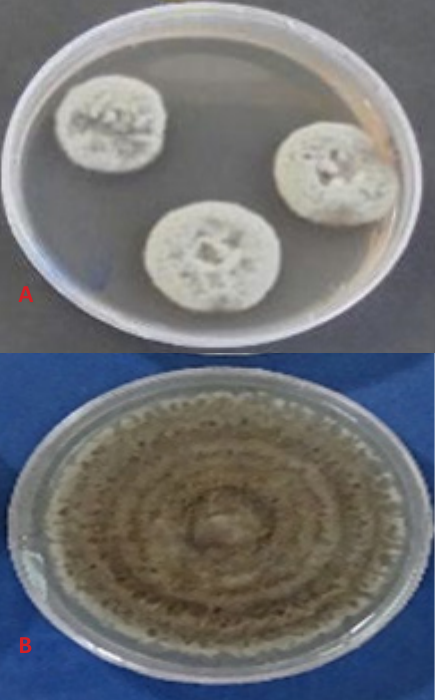
Figure 2 . Leaf samples sown in potato dextrose agar (PDA) medium. A) Fungal mycelia isolated 4 days after sowing. B) Pure culture in PDA medium 13 days after sowing.